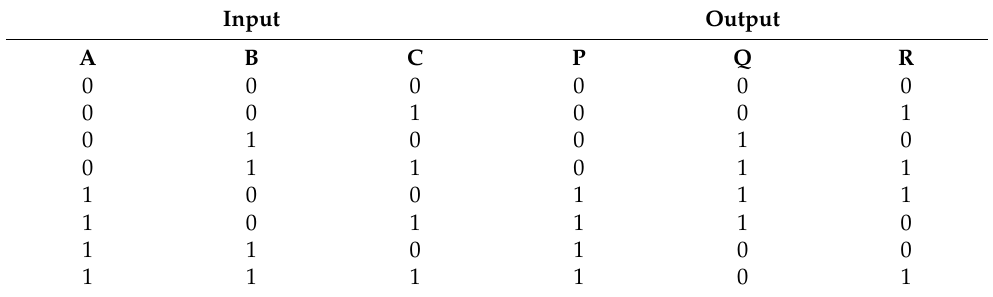
Table 3. Truth table of TR gate.